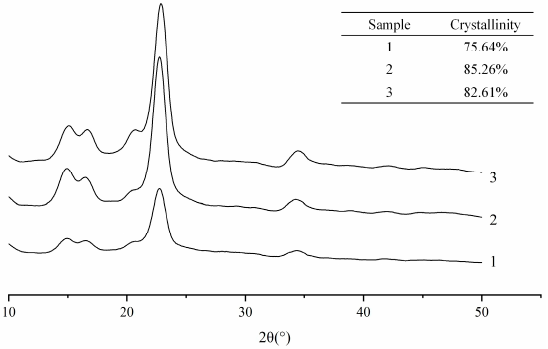
Figure 5. X-ray spectra of (1) the original MCC, (2) the CNCs extracted with swelling − SA − catalyzed hydrolysis method at 45 °C for 5 h, and (3) the extracted CNCs hydrolyzed in 65.0 wt% H 2 SO 4 at 45 °C for 5 h.